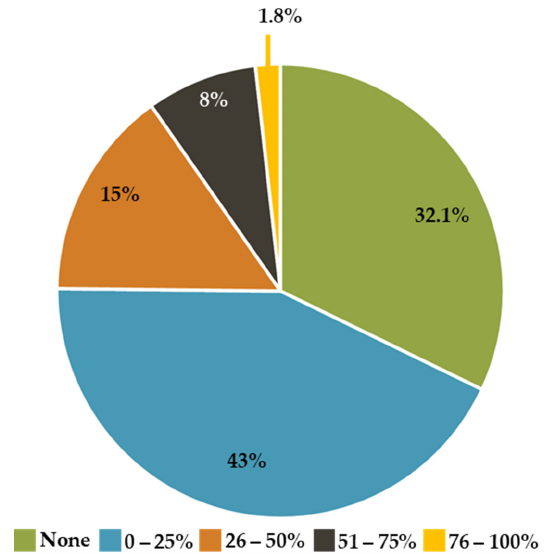
Figure 7. Ability to hire off-farm labor ( n = 866).